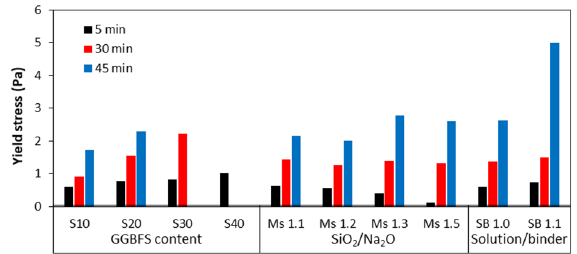
Figure 4. Yield stress of AAM pastes at different elapsed